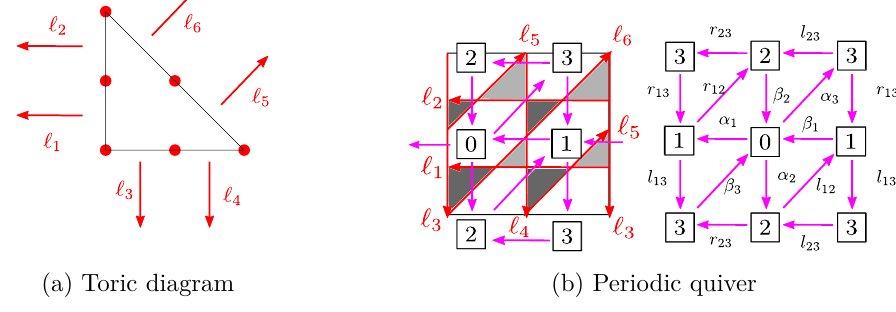
Figure 38. (a) Toric diagram and (b) periodic quiver of C 3 / ( Z 2 × Z 2 ) . The left bottom lattice point of the toric diagram is p = (0 , 0) . Other lattice points are p 1 (1 , 0) , p = (0 , 1) , and p = (1 , 1) . External legs are denoted ‘ 5 6